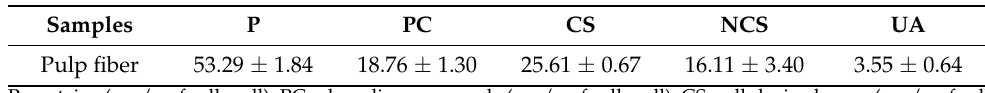
Table 1. Composition of pulp